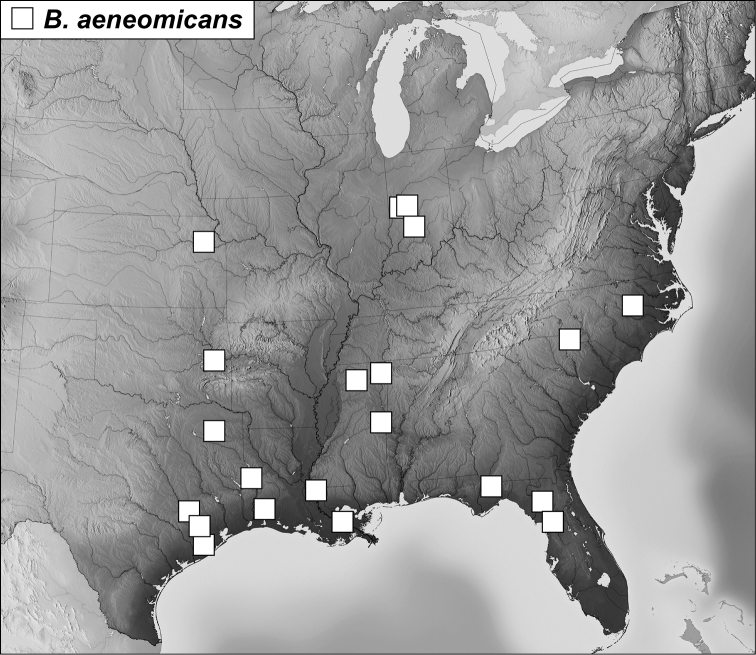
Baconia aeneomicans records.